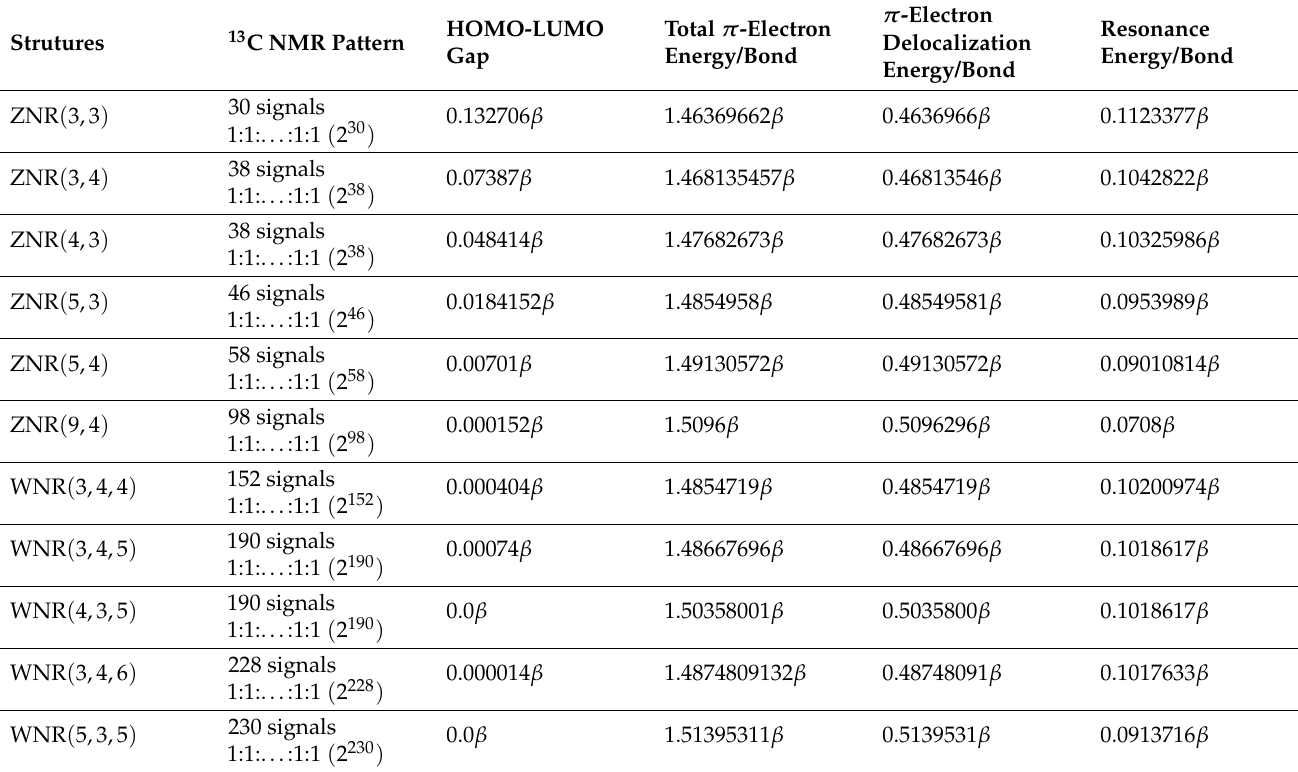
Table 8. Spectral and energetic properties of